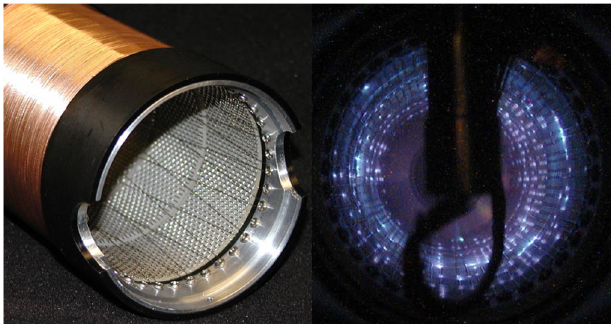
FIG. 8. (Color) Photograph of the BaTiO shutter exposure of the source in operation (right). Plasma is created near the points where the front (inner) mesh electrode is near the surface of dielectric